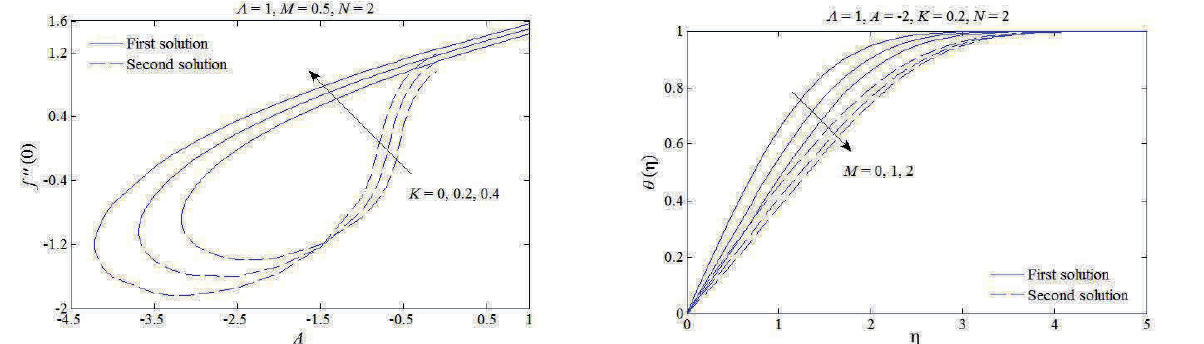
Fig. 4: The Skin friction coefficient f (cid:2)(cid:2) (0) with A for different values of K .